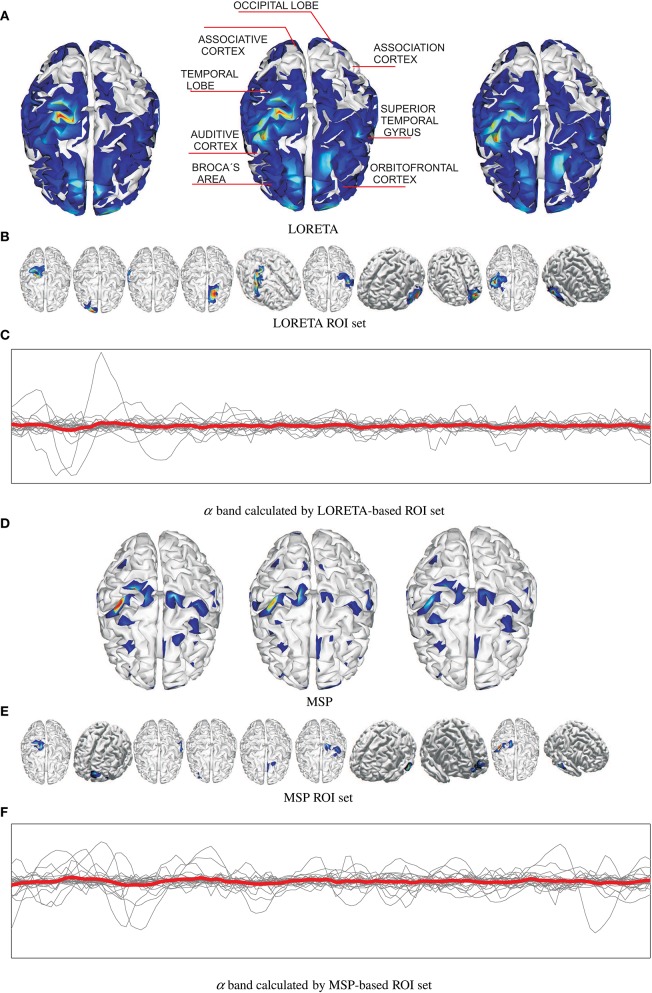
Examples of estimated neural brain activity for N 27, trials labeled as #38, #39, and #40. The activated regions are highlighted. (A) LORETA, (B) LORETA ROI set, (C) α band calculated by LORETA-based ROI set, (D) MSP, (E) MSP ROI set, (F) α band calculated by MSP-based ROI set.